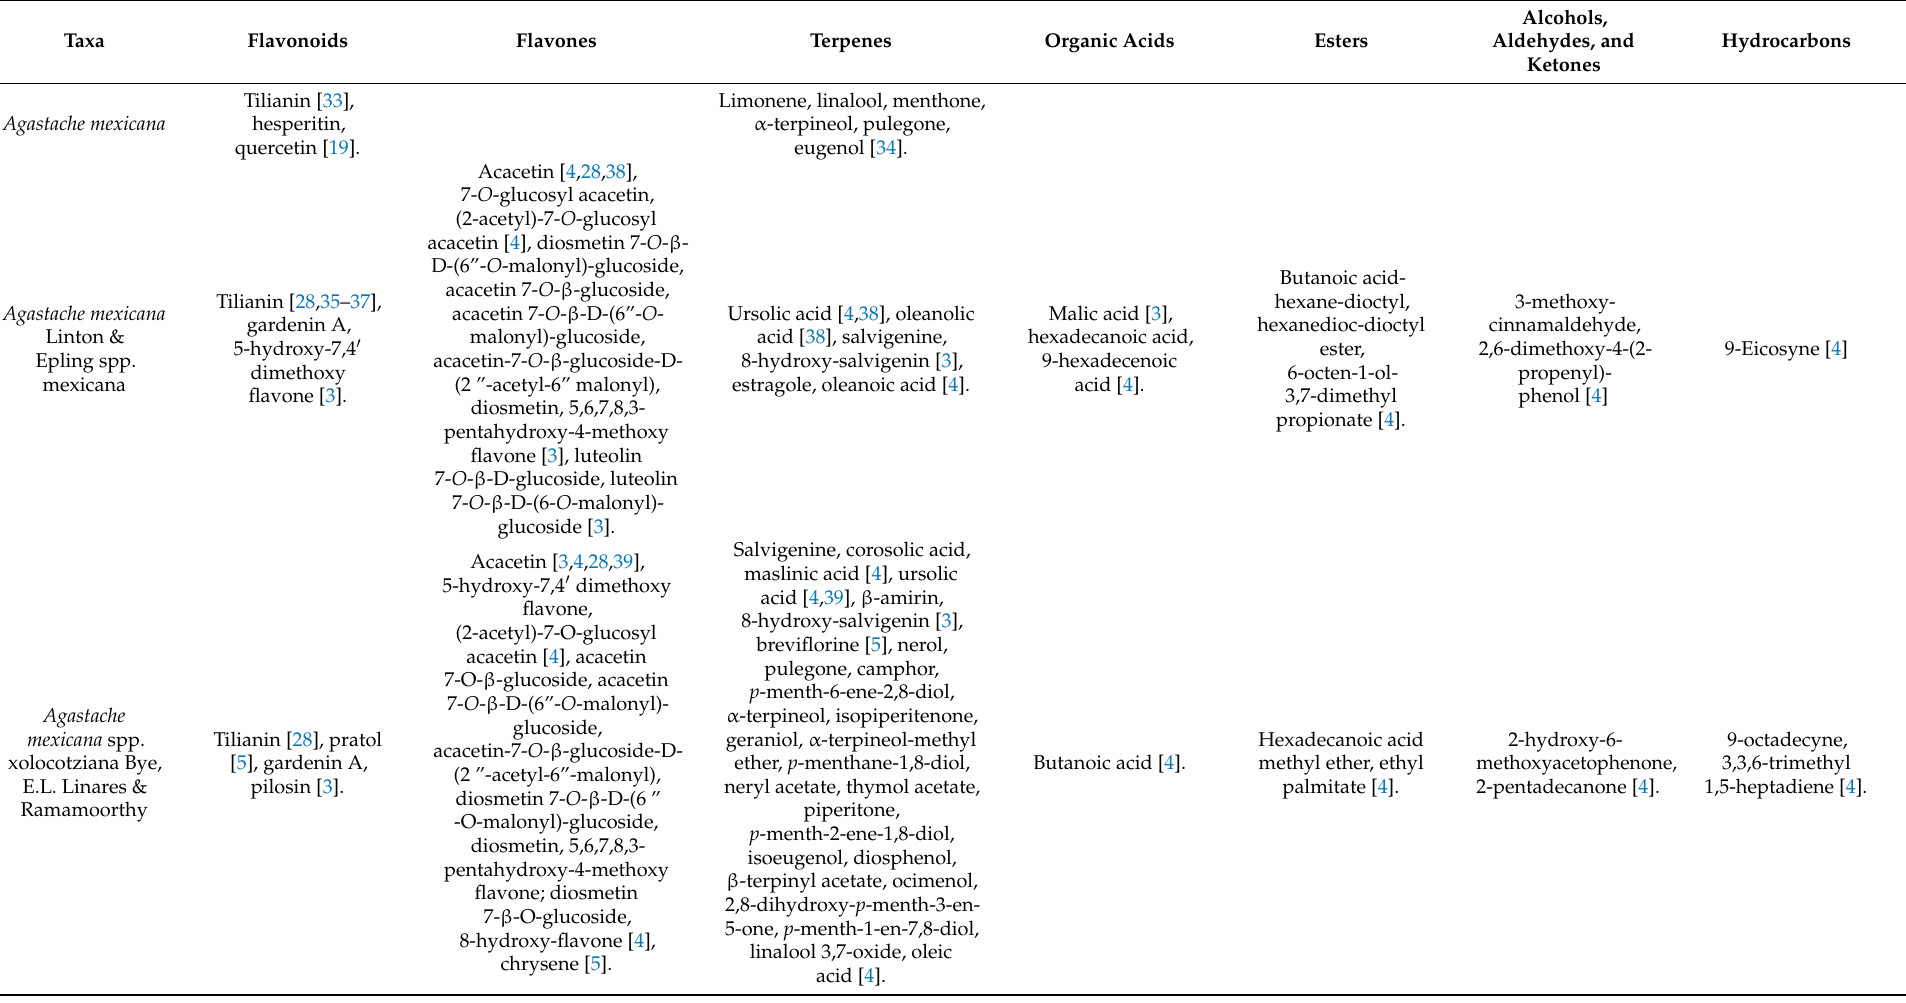
Table 2. Chemical composition of aqueous and organic extracts of Agastache mexicana